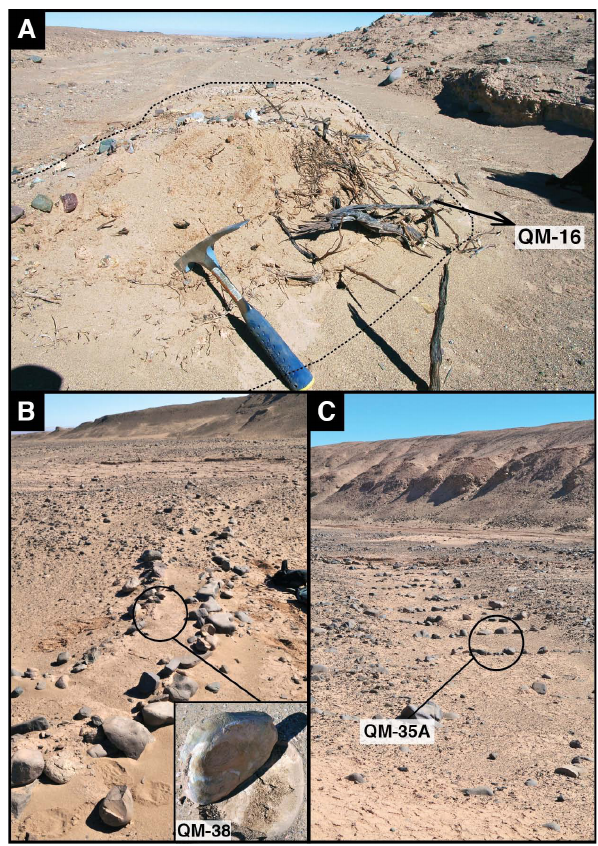
Fig. 4. (a) QM-16 in situ leaf-litter mound. Dashed line describes the deposit extension. (b) Floodplain irrigation channel. Details for Prosopis sp. leaves underneath a stone dam (QM-38 sample) are shown. (c) A “melga” (stone-lined crop field) built on the T2.5 terrace. Circle shows where the QM-35A sample was